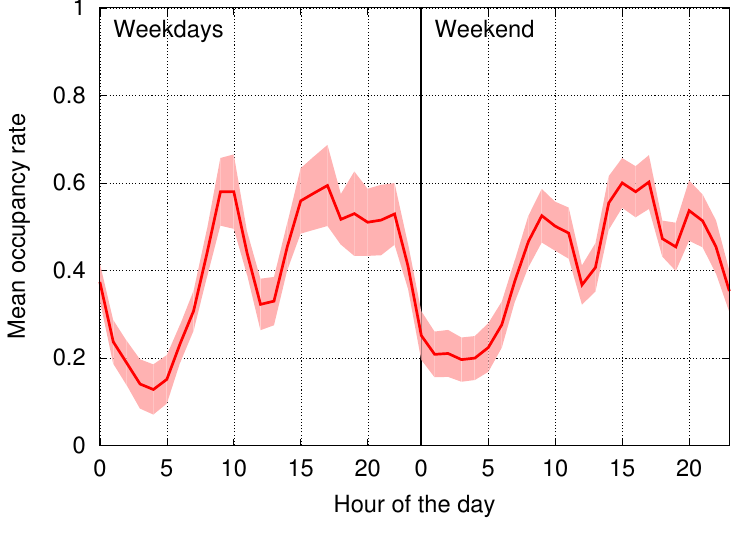
Figure 12. Outlier cluster found through SOM-based